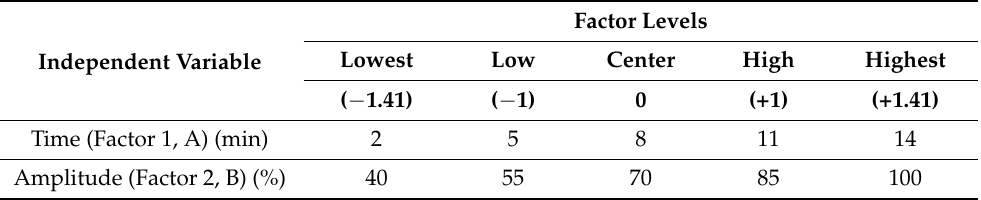
Table 1. Independent variables and their levels in the